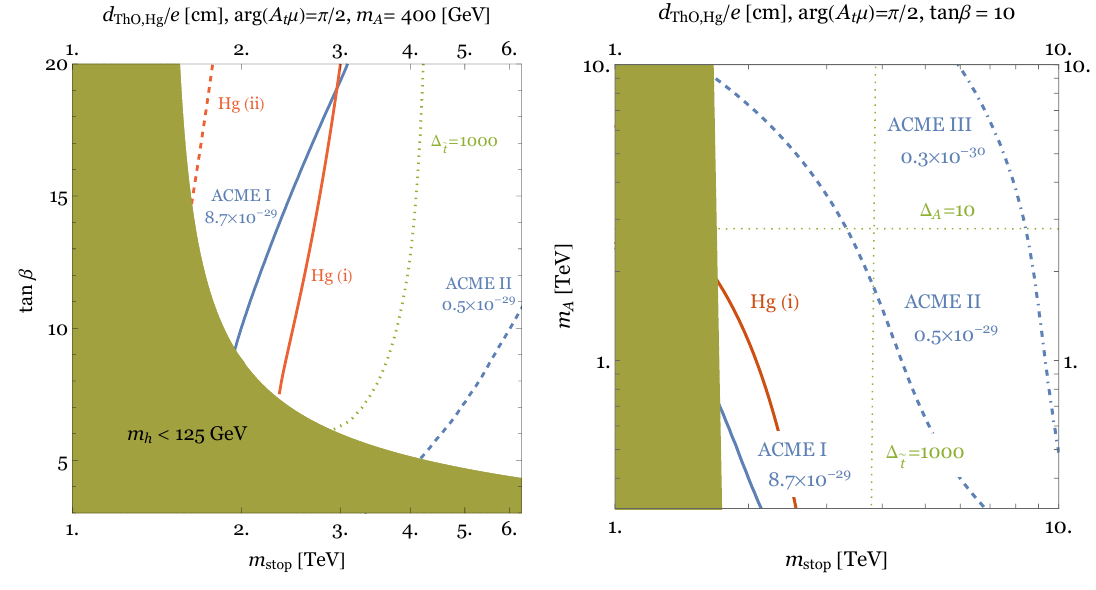
Figure 9 . EDM constraints on the stop parameter space in the MSSM, where stop loops with large A -term lift the Higgs mass to 125 GeV. The horizontal axis shows the common stop soft mass m stop = m Q = m u . At left we (cid:12)x m A = 400 GeV and vary tan (cid:12) on the vertical axis; at right e e 3 3 we (cid:12)x tan (cid:12) = 10 and vary m A on the vertical axis. In the brown/green shaded region, no choice of A t is su(cid:14)cient to achieve the correct Higgs mass. In the rest of the parameter space, at each point we choose A t to achieve m h = 125 GeV. Regions of parameter space to the left of the solid blue contours are excluded by measurements of ThO. Red solid and dashed contours denote the mercury EDM constraints for the cases (i) and (ii) discussed in appendix C), respectively. The blue dashed and dot-dashed contours (\ACME II" and \ACME III") are future projections. The dotted green lines display the stop (cid:12)ne tuning (3.4) and tree-level Higgs (cid:12)ne tuning (3.3). We have (cid:12)xed j (cid:22) j = 350 GeV in these